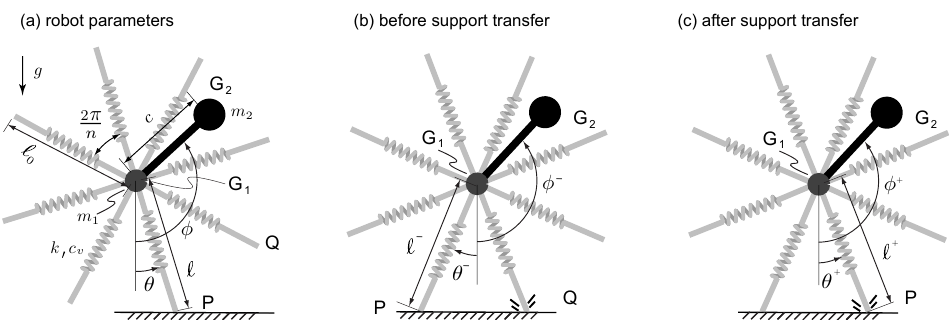
Figure 6. Planar model: The robot is progressing from left to right. ( a ) The robot parameters used in the simulation, ( b ) the robot at an instant before support transfer, and ( c ) the robot at an instant after support transfer. All state variables before and after support transfers are appended a superscript − and + respectively. The point P is the current spoke touching the ground and point Q is the spoke that will touch the ground on the next step. Note that the robot has 10 legs on each side but only 8 spokes are shown in the